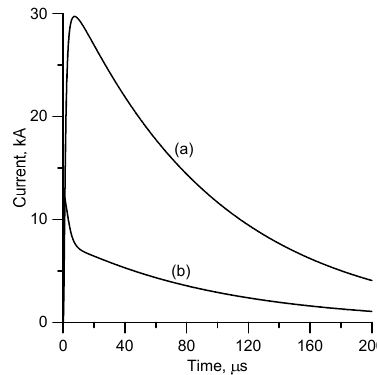
Figure 1. ( a ) First and ( b ) subsequent return stroke channel base current waveforms used in deriving the return stroke electromagnetic fields from the MTL models.